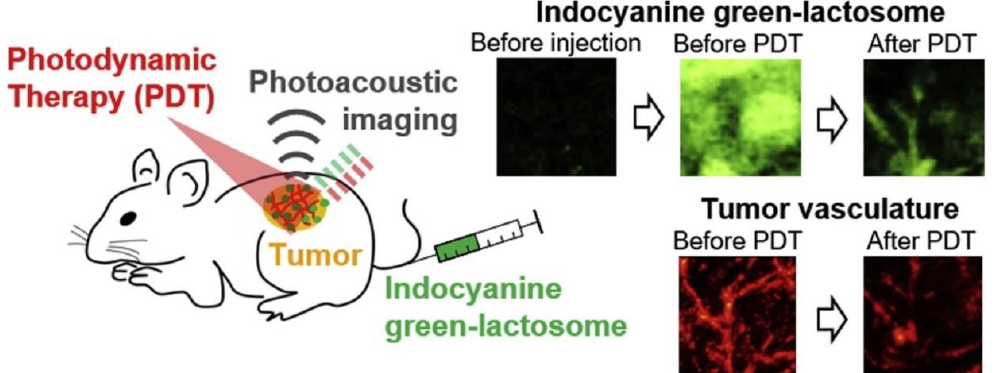
Figure 3. Schematic of photodynamic therapy (PDT) and photoacoustic imaging with ICG-lactosomes. Photoacoustic images (3.9 × 3.9 mm 2 ) show the accumulation of ICG-lactosomes in the tumor (before PDT). The photoacoustic probe was automatically scanned over a 3.9 mm × 3.9 mm region of interest with a step size of 50 and 150 μm for imaging of blood vessels and ICG distribution, respectively. The wavelength of the short laser pulse was 532 nm for photoacoustic imaging of oxy- and deoxy-hemoglobin in blood vessels. The laser pulse at 796 nm was used for ICG imaging. Re- sults of the fluorescence imaging of ICG showed that the photoacoustic imaging decreased by only 0.78% in average fluorescence intensity originating from ICG in the tumor (data not shown), indi- cating a negligible photobleaching by the laser light for photoacoustic imaging. After PDT, the pho- toacoustic signal was drastically decreased, suggesting photobleaching in the tumor. (Reprinted from Tsunoi et al. [13] with permission from Elsevier).